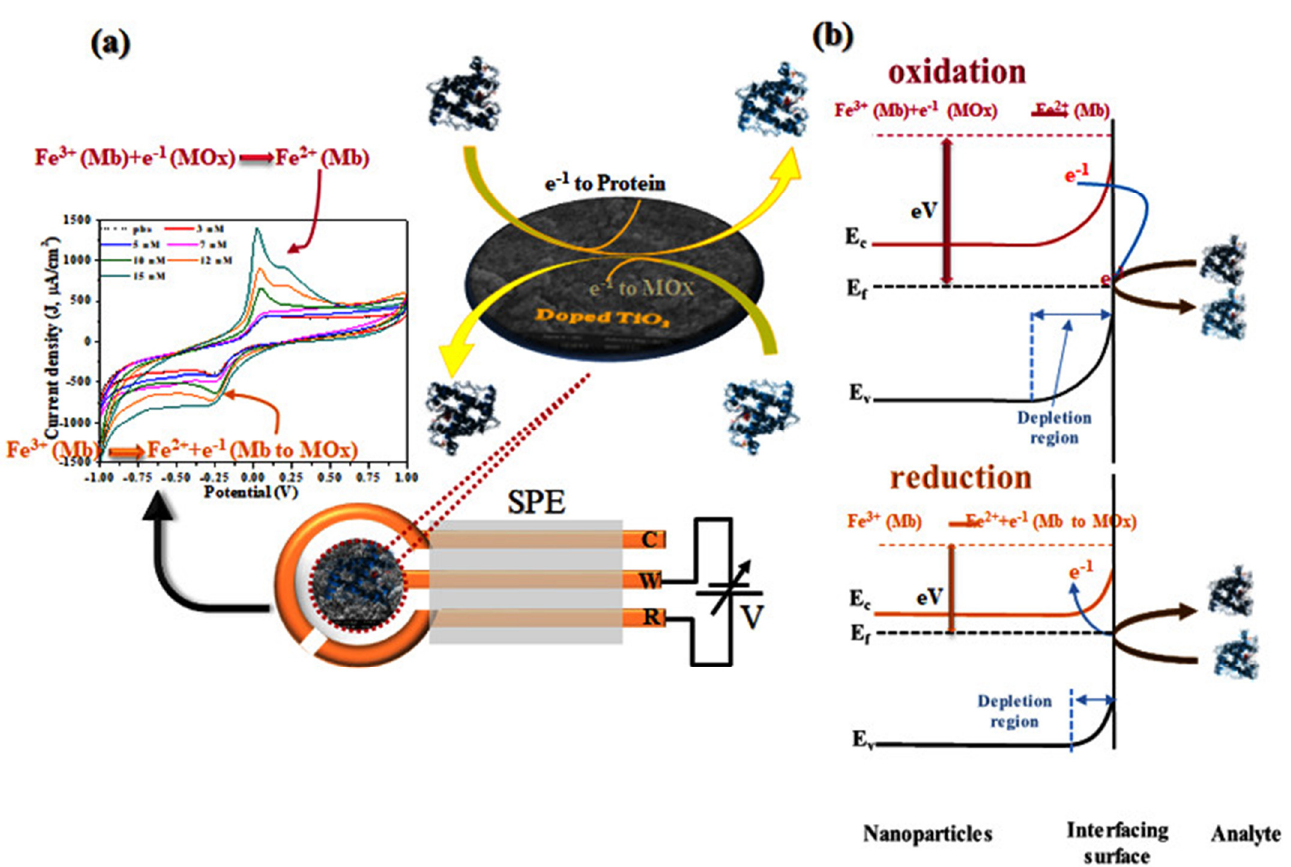
Figure 9. Proposed sensing mechanism ( a ) process of reaction mechanism ( b ) charge transfer characteristics.